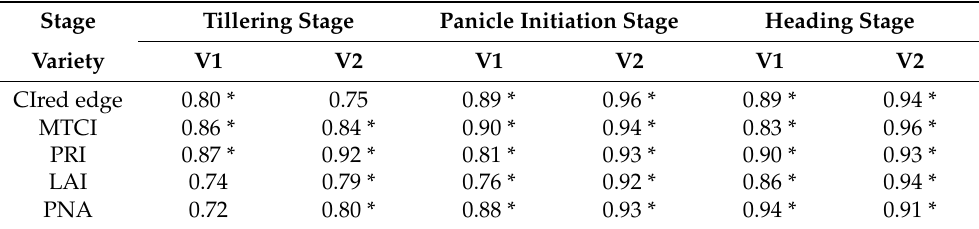
Table 7. Correlations of grain protein content (GPC) with vegetation indices, leaf area index (LAI), and plant nitrogen accumulation (PNA) for rice varieties V1 (Meixiangzhan 2) and V2 (Wufengyou 615) at different growth stages ( n = 15).